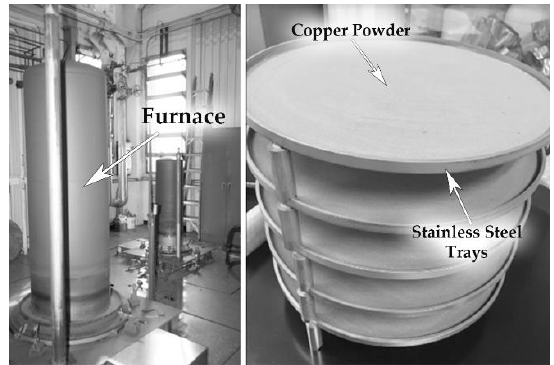
Figure 1. Hydrogen brazing furnace at SLAC National Accelerator Laboratory Technology Innovation Directorate (TID) (left), and stacked-stainless steel fixture (right) for treating multiple trays of copper powder in 2-mm thick layers.